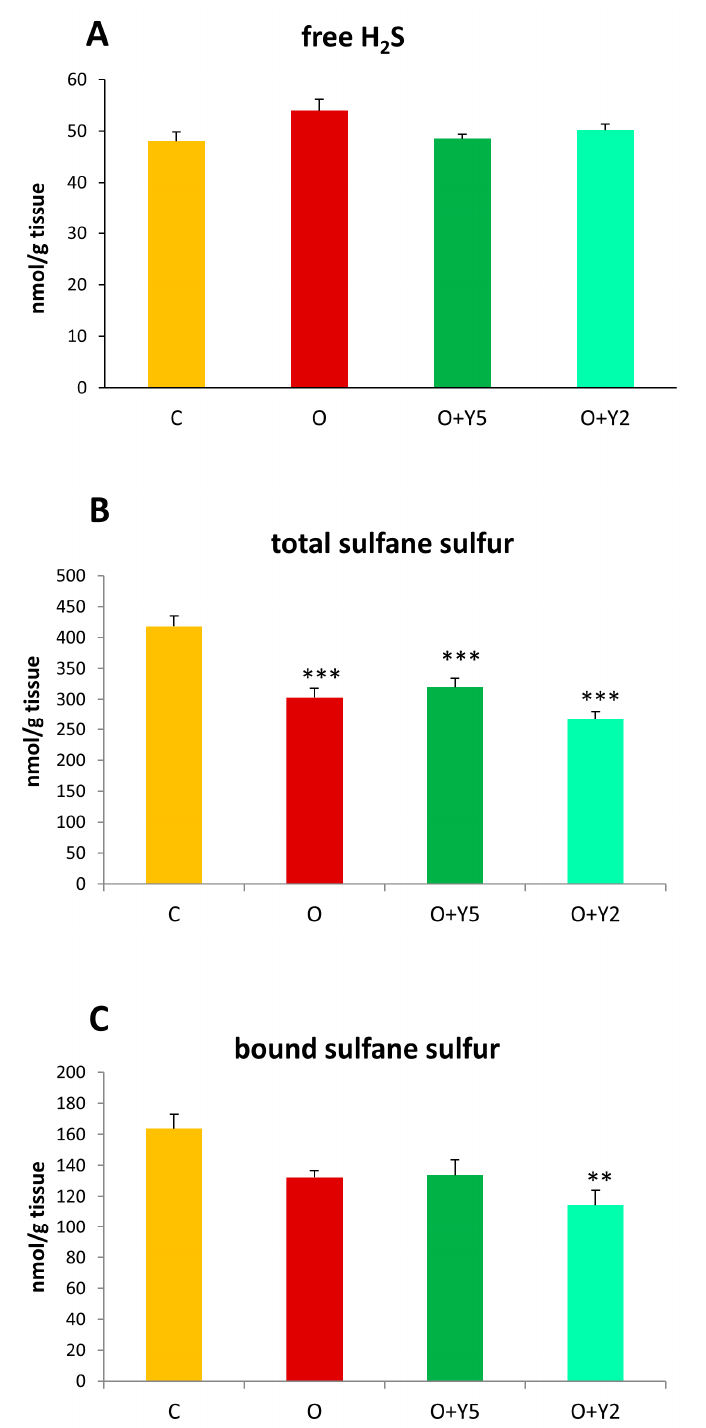
Figure 2. Concentrations of the free H 2 S ( A ), total sulfane sulfur ( B ), and bound sulfane sulfur ( C ) in the livers of rats. C—control rats fed a standard diet; O—rats fed with HFD; O + Y5—rats fed with HFD and treated intraperitoneally (i.p.) with yohimbine at a dose of 5 mg/kg/day for 30 days; O + Y2—rats fed with HFD and treated intraperitoneally (i.p.) with yohimbine at a dose of 2 mg/kg/day. Data are presented as the mean ± SEM, n = 6 per group. Statistical analysis was performed using a one-way ANOVA; symbols indicate significance of differences according to the Tukey post hoc test, ** p < 0.01, *** p < 0.001 vs. group C.